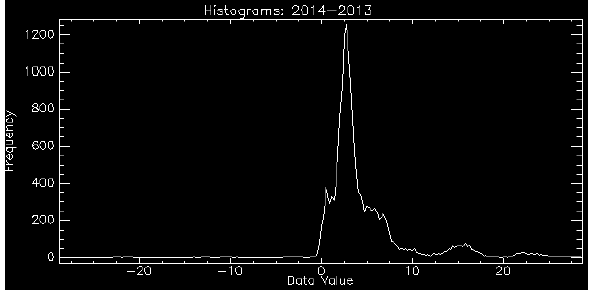
Figure 12. Histogram of the difference between the 2014 and 2013 depth maps.